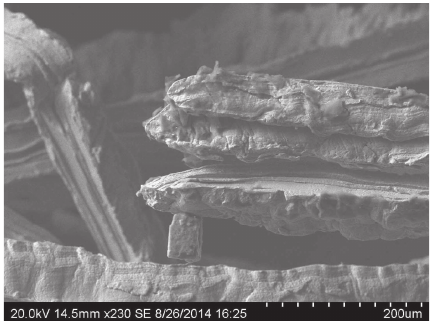
Figure 8: SEM image of fractured metal fibers in OLPM.